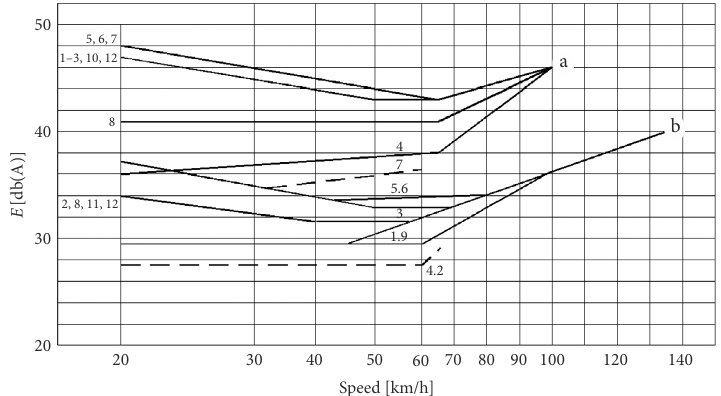
Figure 3. Acoustic emission E [dB(A)] as a function of the type, nature, and speed of the vehicle: a – truck, b – motorcar; character of movement: 1 – continuous sloping, 2 – pulsating with a slope, 3 – acceleration with a slope, 4 – deceleration with a slope, 5 – continuous with a rise, 6 – pulsating with a rise, 7 – acceleration with a rise, 8 – slowdown with a rise, 9 – continuous downhill operation, 10 – pulsating downhill operation, 11 – acceleration at downhill operation, 12 – deceleration at downhill